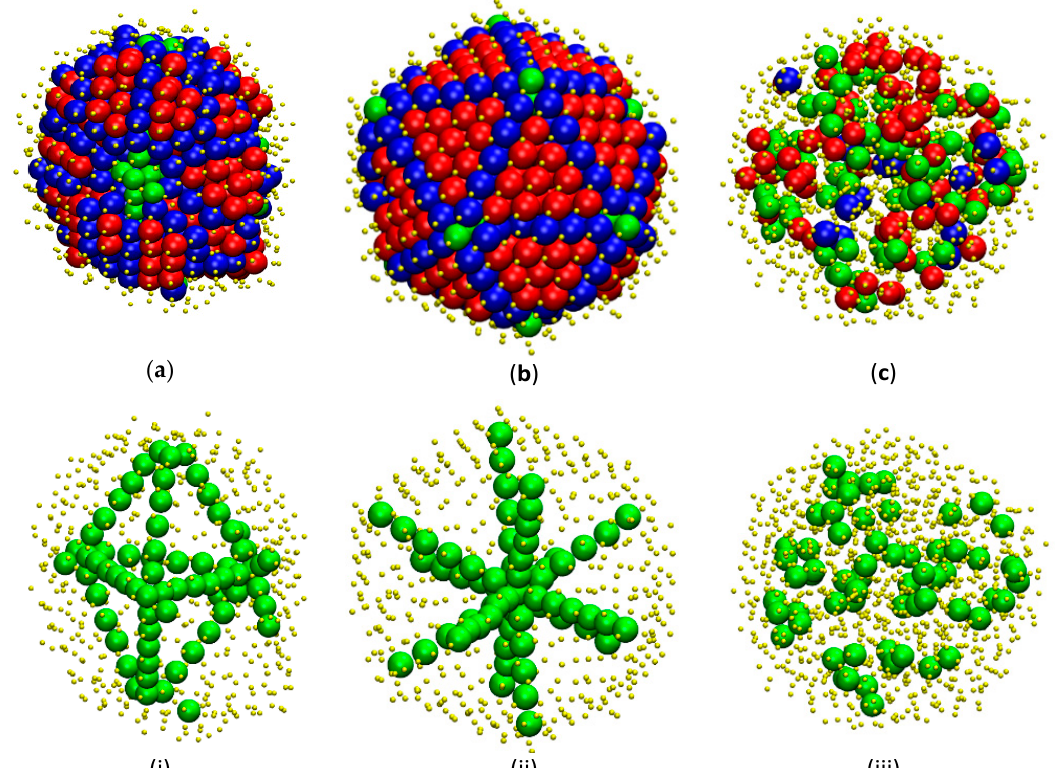
Figure 8. Top row (panels a–d ): system snapshots of square well chains interacting with the following parameters: ( a ) ε = 1.0 and σ 2 = 1.2; ( b ) ε = 1.3 and σ 2 = 1.2; ( c ) ε = 2.0 and σ 2 = 1.2. Sphere monomers are color-coded according to the CCE norm: Blue, red and green correspond to HCP-, FCC- and FIV- like sites, respectively. Amorphous (neither HCP/FCC nor FIV) monomers are shown in yellow and with reduced radii to enhance clarity. Bottom row (panels i–iii ): same configurations but showing only fivefold and amorphous sites. 3-D, interactive versions of the figure panels exist in supplement material (as well as a 3-D, interactive version of the present manuscript).